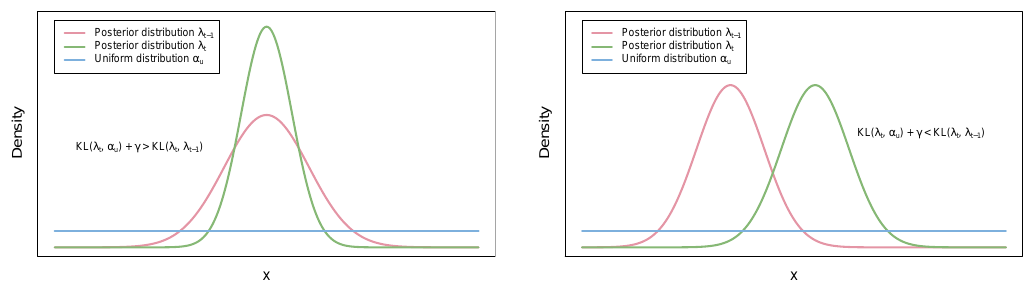
Posterior distribution l t - 1 Posterior distribution l t Uniform distribution a u